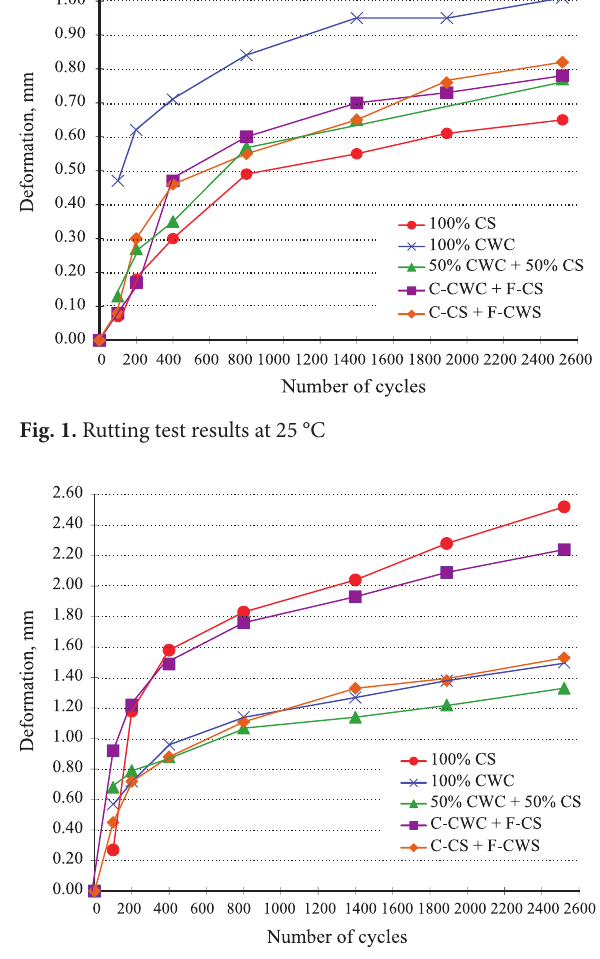
Fig. 3. Resilient modulus test